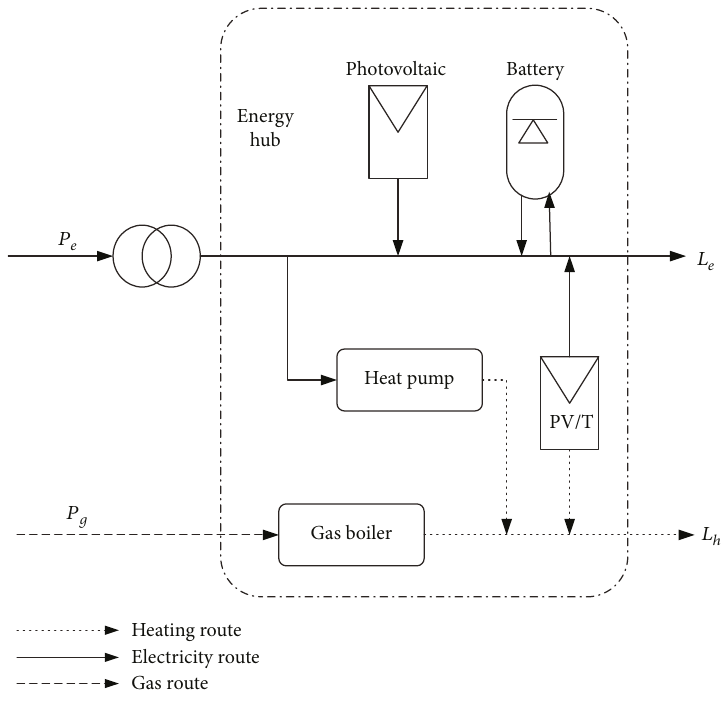
Figure 12: Ultimate energy hub structure for a building.